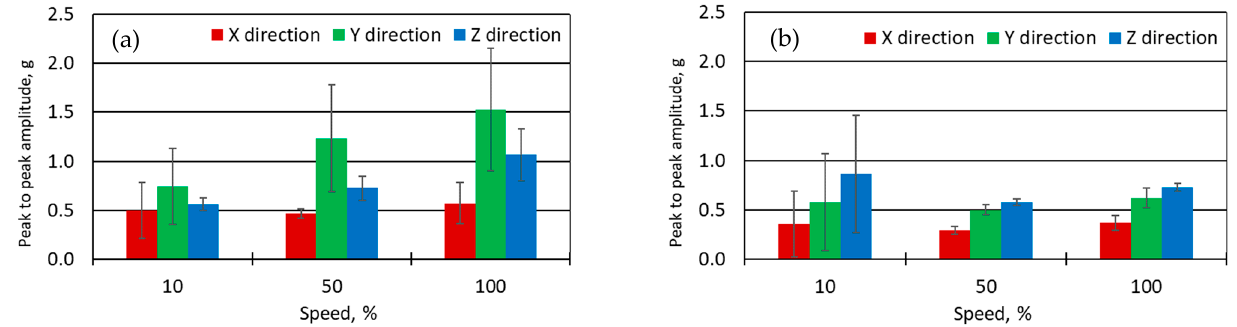
Figure 10. Peak-to-peak vibrations amplitudes: ( a ) at the start (measuring) position (Figure 3a), ( b ) at the endpoint of the trajectory (Figure 3b). Statistical evaluation was performed according to Equations (8)–(13).